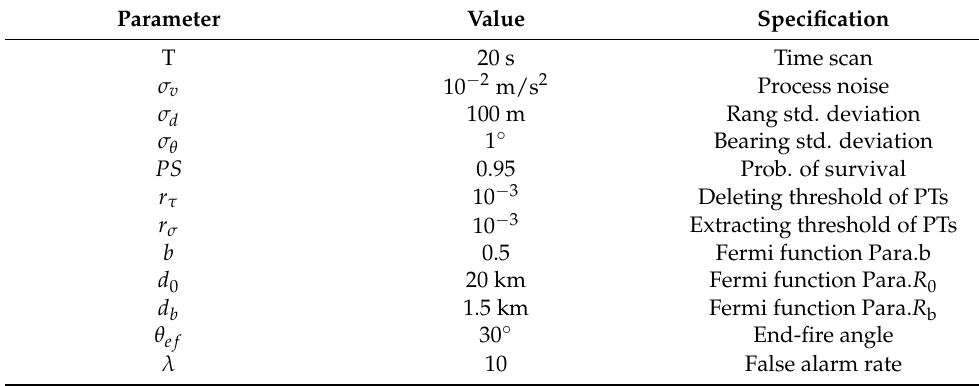
Table 1. Simulation parameters.